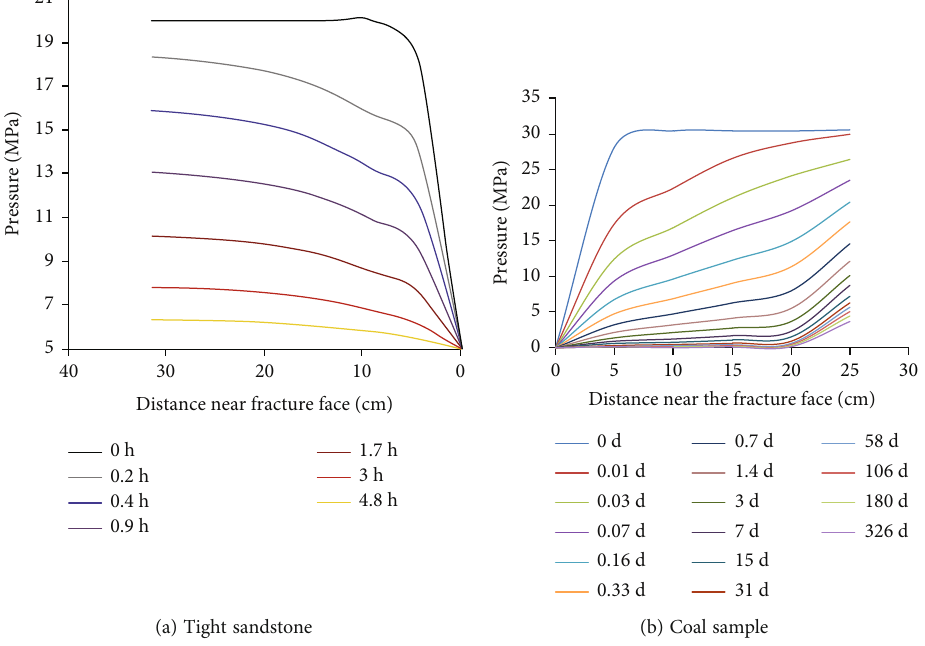
Figure 4: Pressure pro fi le curve of tight sandstone and